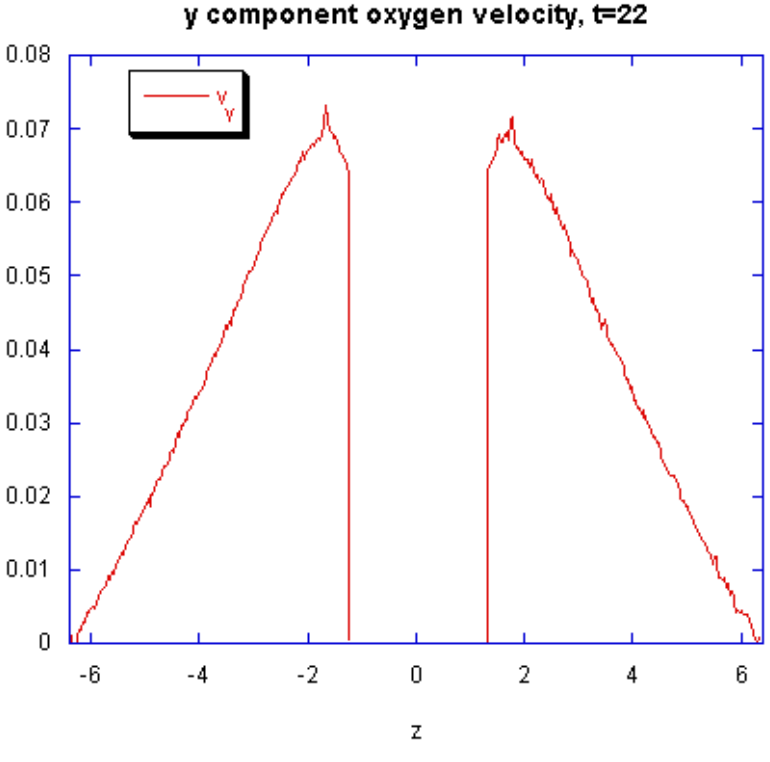
Fig. 6. The y component of the oxygen velocity, taken at x = 12 . 8 and t =